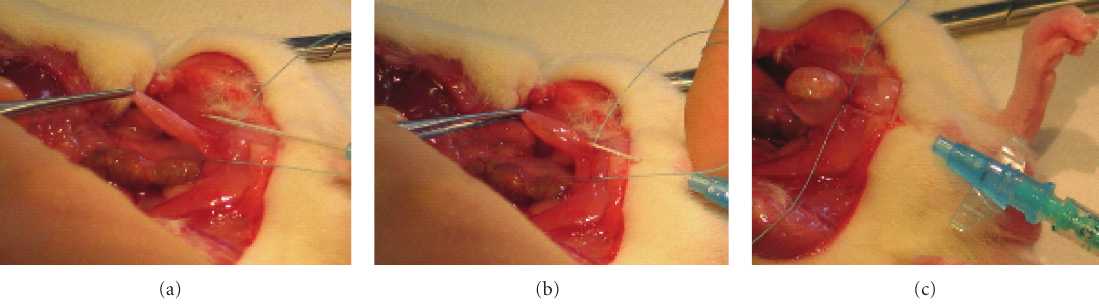
Figure 2: Lysis of the rat bladder urothelial cell layer in situ . (a), (b) On a fully anesthetized rat, the bladder is exposed through an abdominal incision, a thin needle or catheter (27G) is introduced into the bladder at the bladder neck, and ligated in place with a silk suture. (c) The bladder is emptied for urine, and filled with approximately 0.5 mL lysis solution (4M guanidine isothiocynate, 0.5% sarcosine, 25 mM citrate, pH 5.5), which is left in place for 2 minutes and withdrawn. The resulting urothelial lysates can be used for RNA isolation or protein analysis by Western, as described in [28]. By infusing a trypsin solution into the bladder lumen, suspensions of urothelial cells for flow cytometric analysis can be made